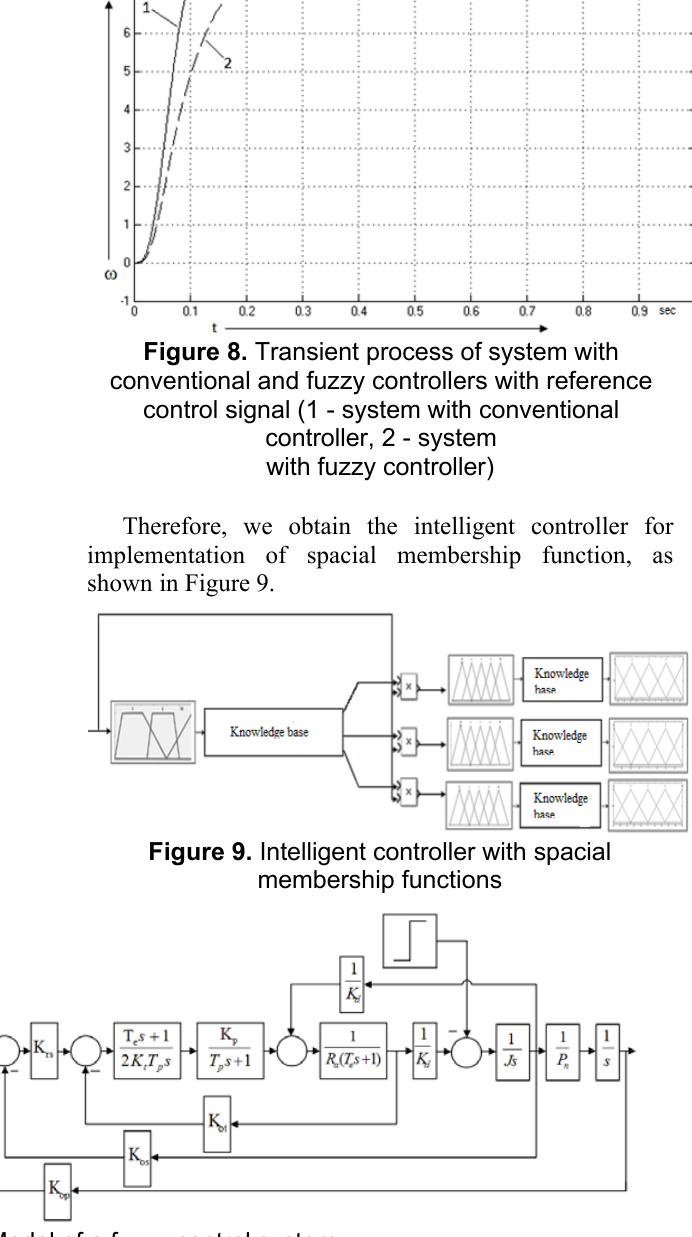
Figure 7 . Model of a fuzzy control